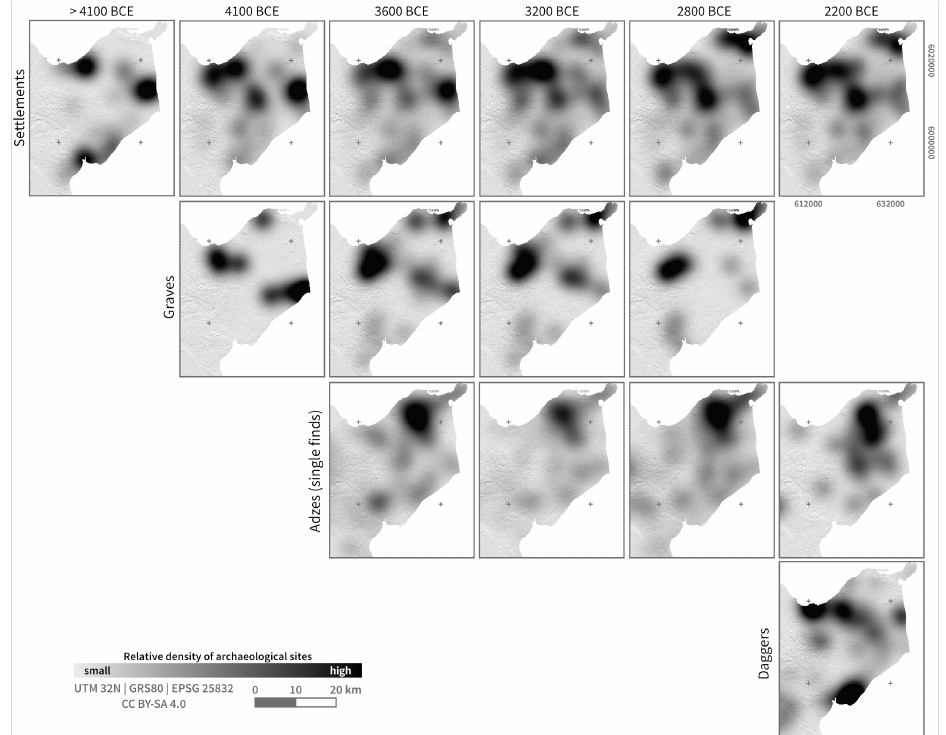
Figure 5. Absolute location differences as reflected by density differences in archaeological sites during Neolithic transformation phases (Rows indicate the different archaeological sources and context; columns correspond to the different Neolithic phases, whose starting dates are shown. The utilized archaeological sample corresponds to all finds that belong to the different